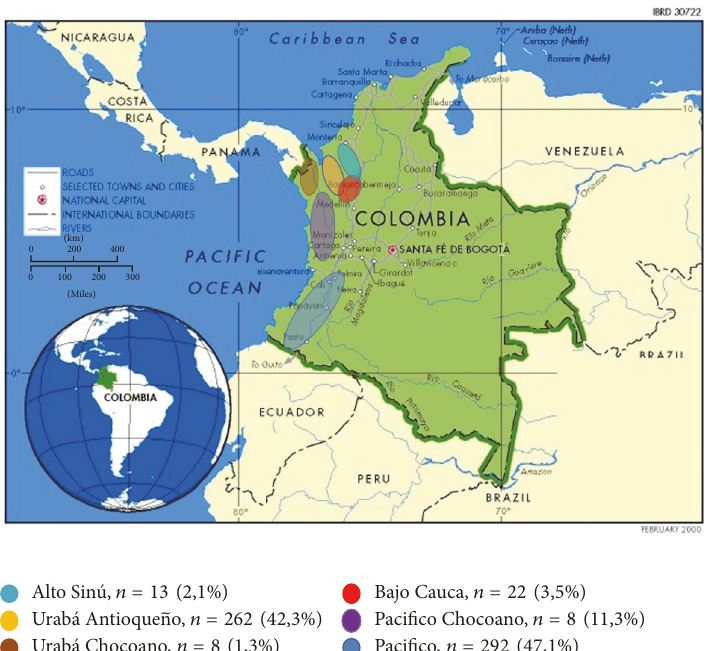
Figure 1: Geographical locations of the regions of origin of 618 patients, obtained and modified from the Cartographic Design Unit of the World Bank,